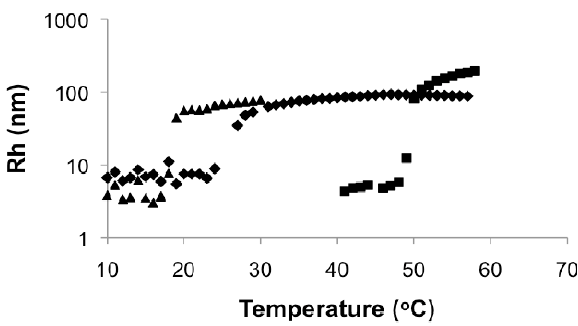
Figure 10. Hydrodynamic radii of particles (R ) as a function of temperature of h poly(DMAEMA- stat -styrene) with 96 mol% DMAEMA (DMAEMA/S-95/5, (cid:132) ), 81 mol% DMAEMA (DMAEMA/S-80/20, ▲ ) and block copolymer (D/S80/20-b-D/S95/5, (cid:139) ) in de-ionized water at 0.1 wt%